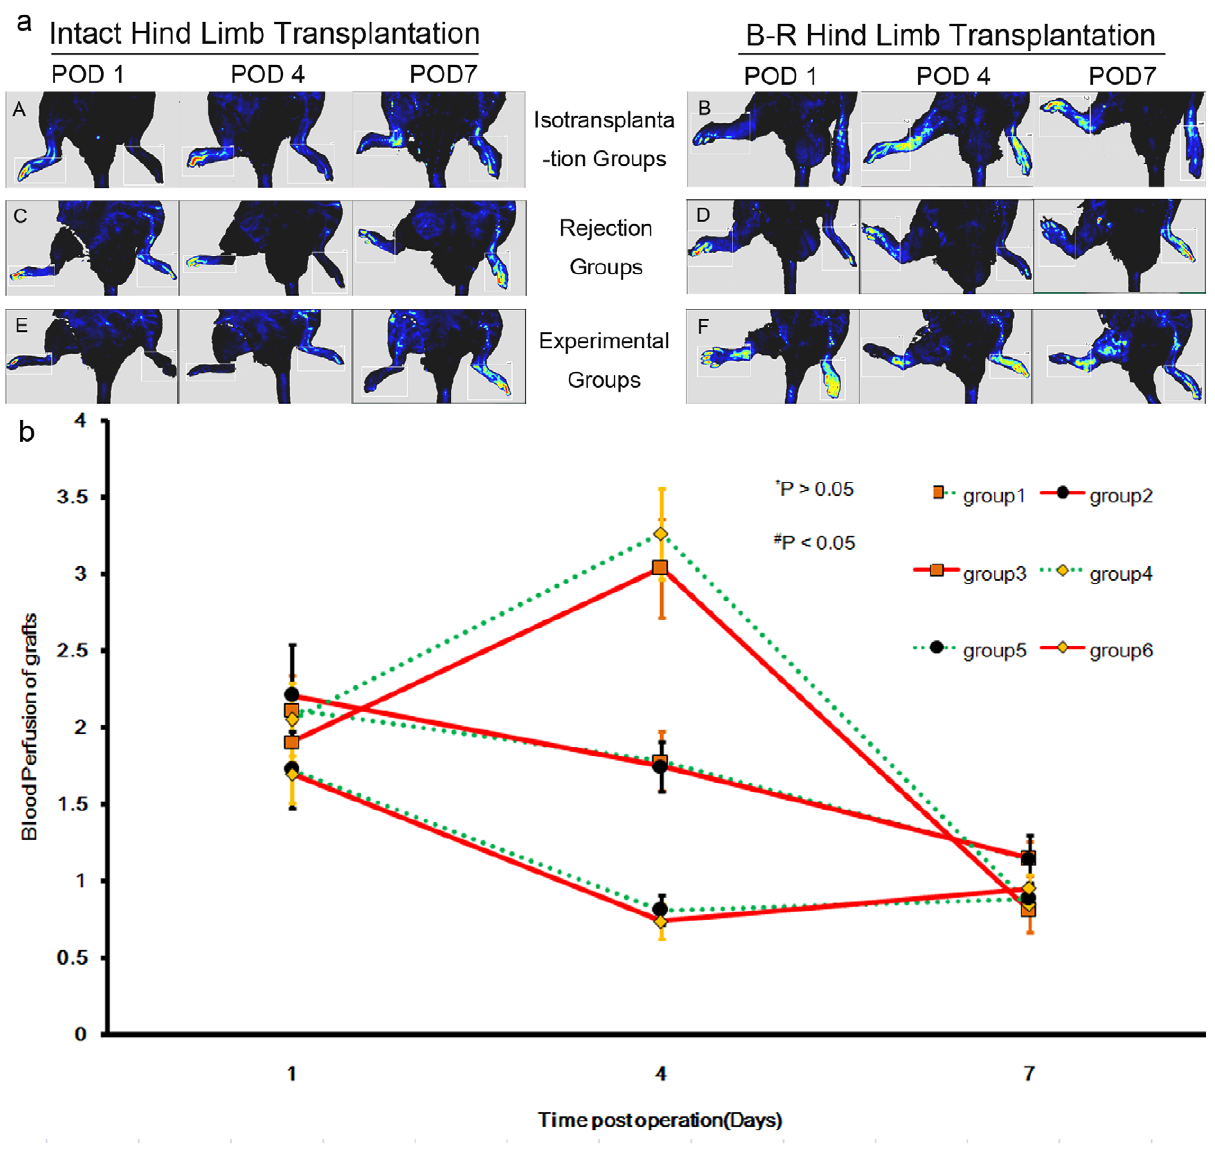
Figure 2. Dynamic changes of blood perfusion in grafts of the recipients. (a) All transplantations were successful, as confirmed by the considerable blood supply of the transplanted grafts according indicated by LDF. (b) The perfusion ratio between intact hind limbs and B–R hind limbs in each group was analyzed. Blood perfusion in isograft controls showed a smooth course of recovery during the observation period. In rejection groups, it peaked at POD 4 and then decreased sharply to a level below that of the contralateral limb. Blood perfusion became undetectable when they were rejected at POD 11. The blood perfusion of transplanted grafts in experimental groups remained low at all times, and ebbed at POD 4. Then it increased to a level below that of the contralateral limb at POD 7. Mean blood perfusion of grafts did not show any significant differences between any two groups given the same treatment at any point in time point ( * P . 0.05). In contrast, all pairs of rejection and experimental groups showed statistical differences at POD 4 ( # P ,